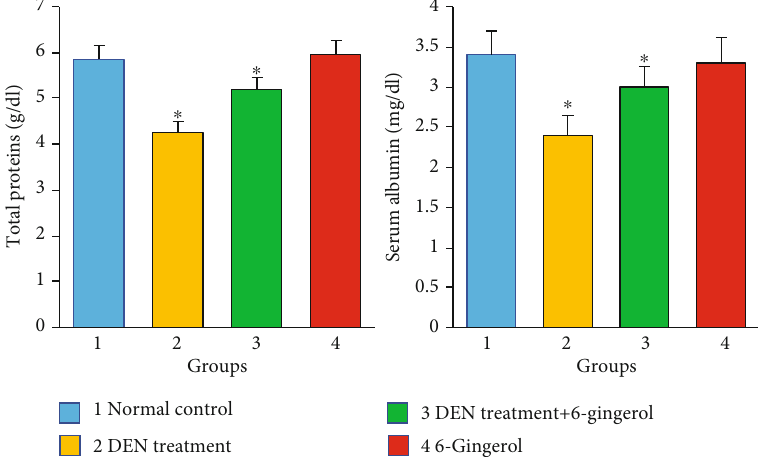
Figure 6: Signi fi cant reductions in the concentration of total protein and albumin were seen in the DEN-treated group, and pretreatment with 6-gingerol signi fi cantly increased the concentrations of such proteins ( p < 0 : 05